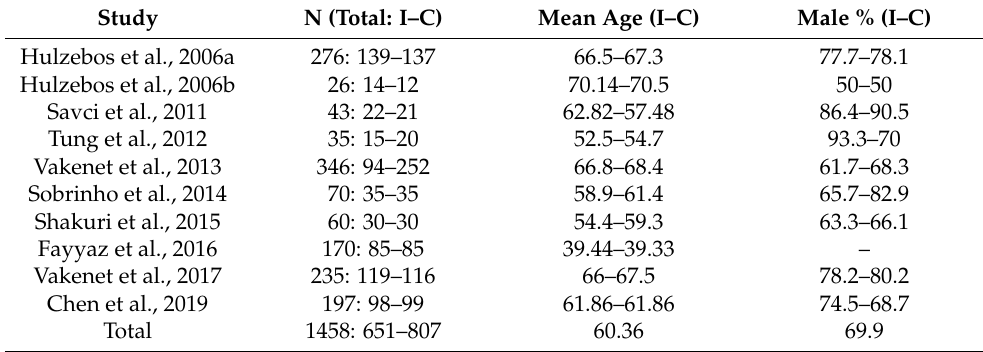
Table 2. A summary of the sociodemographic data included in the studies.